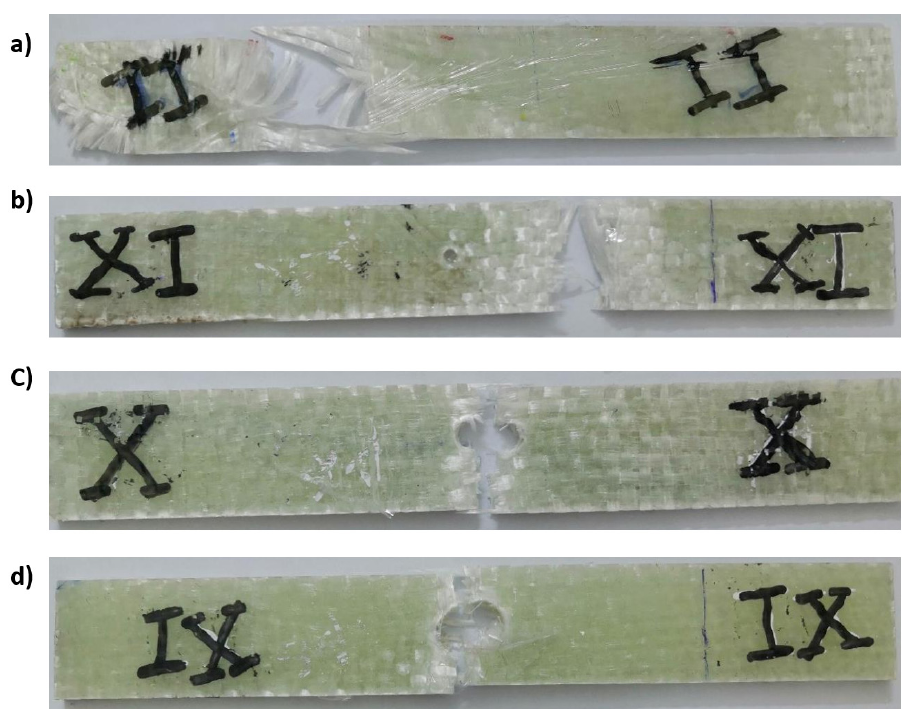
Figure 18. Failure modes in the relaxation test for GFRP with hole diameters ( a ) no notch, ( b ) 4 mm, ( c ) 8 mm, ( d ) 12 mm.